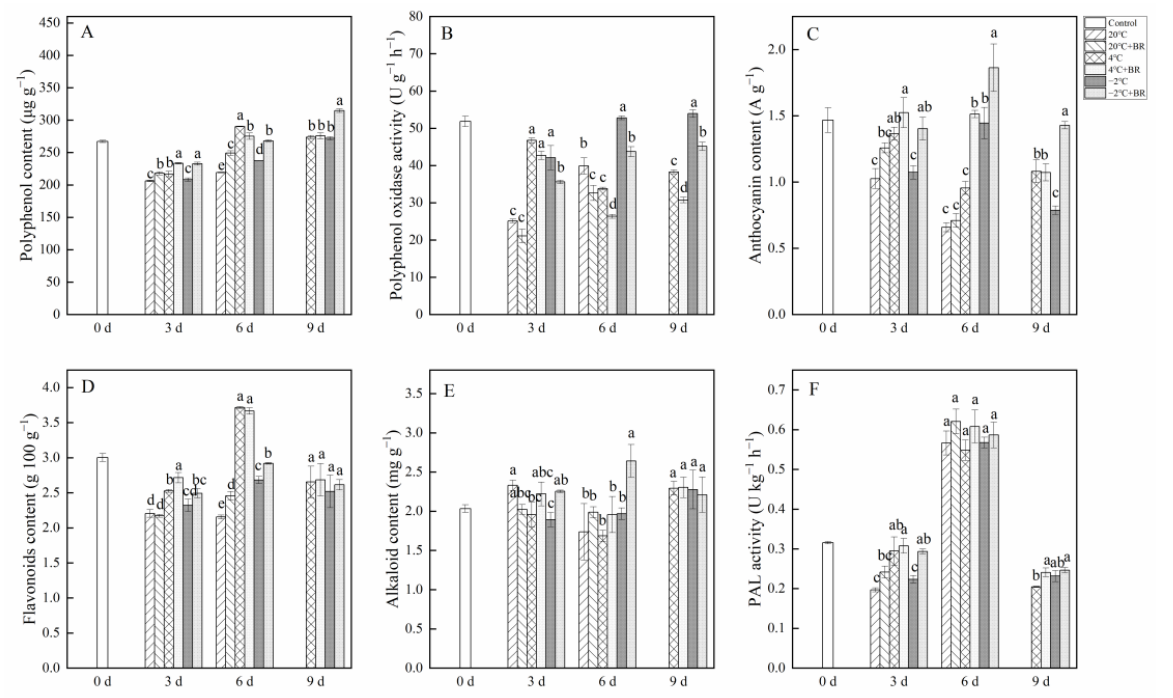
Figure 4. Effects of BR treatment on polyphenol content ( A ), polyphenol oxidase activity ( B ), antho- cyanin content ( C ), flavonoids content ( D ), alkaloid content ( E ), and PAL activity ( F ) of T. sinensis during different temperature storage. Bars with different letters are significantly different at the same storage time under different temperatures and BR treatment ( p < 0.05). Values are the mean of four replicates ± SE.